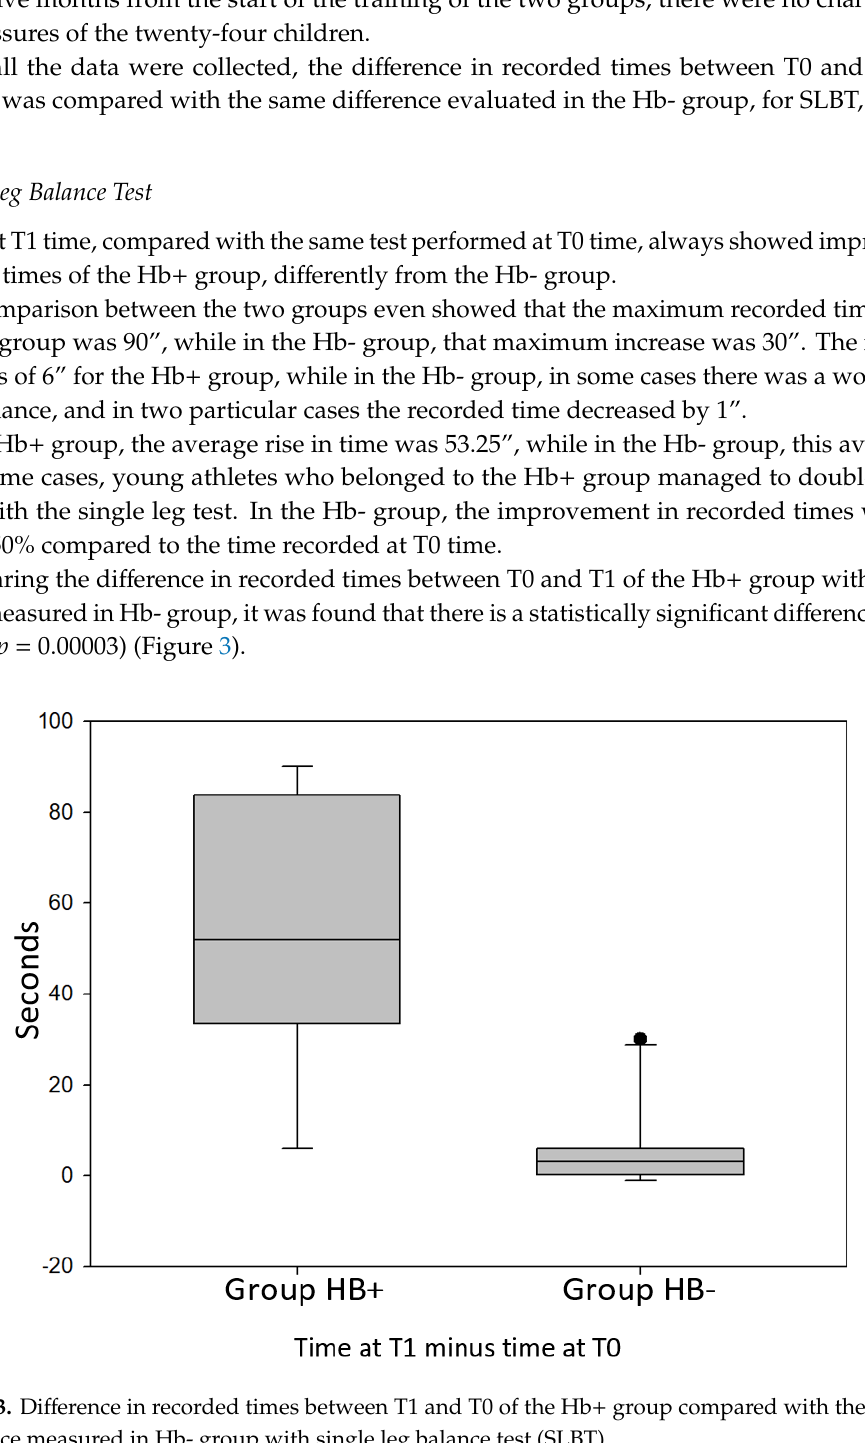
Figure 3. Difference in recorded times between T1 and T0 of the Hb+ group compared with the same ff erence measured in Hb- group with single leg balance test difference measured in Hb- group with single leg balance test (SLBT). di